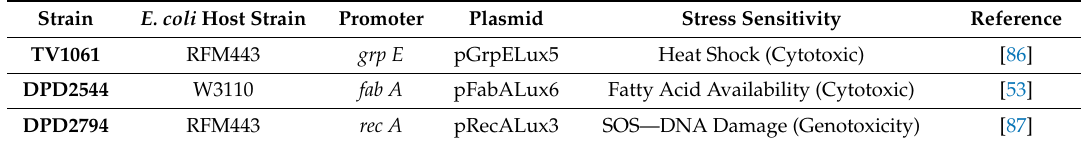
Table 4. Bioluminescent bacterial